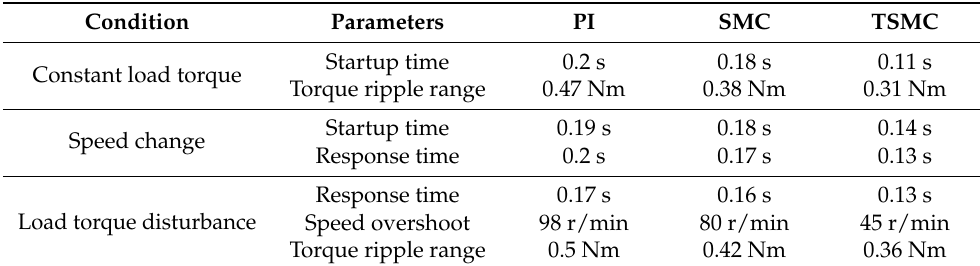
Table 1. Experimental results of the three